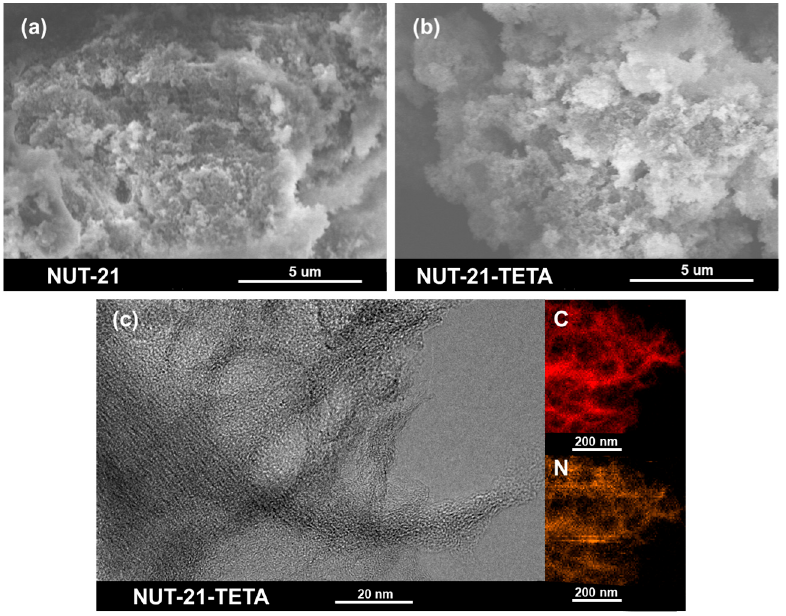
Figure 4. SEM images of ( a ) NUT-21, ( b ) NUT-21-TETA, and ( c ) TEM EDX mapping of the NUT-21- TETA.